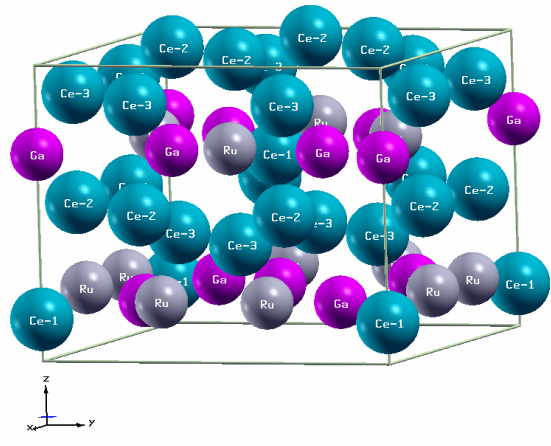
Figure 1. Tetragonal unit cell of Ce 9 Ru 4 Ga 5 (space group I4 mm , No 107). The structure details are given in Table